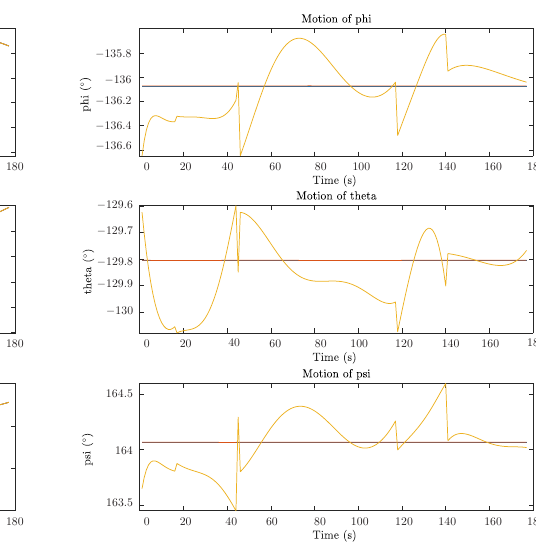
Figure 9. Decoupled motions in each